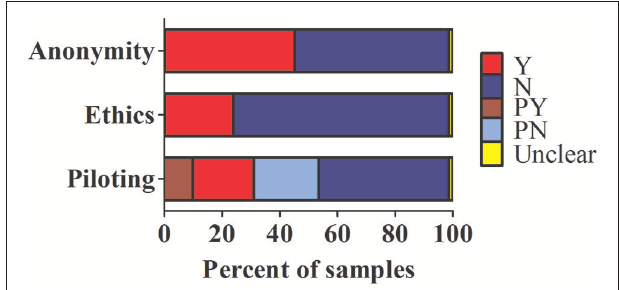
FIGURE 2 | Summary of key quality metrics; were participants guaranteed anonymity, did the study report ethical approval, and was the survey instrument piloted before use. The percentage of samples meeting each criterion is shown in red (Y), while those which did not are shown in blue (N). For the piloting analysis, those samples which piloted the instrument before use and used a previously published instrument are dark red (PY), while those using an established instrument without piloting are pale blue